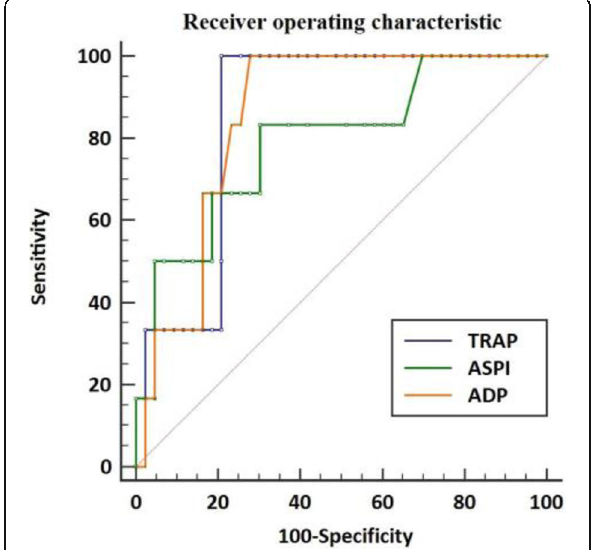
Fig. 1 (abstract A68). See text for description